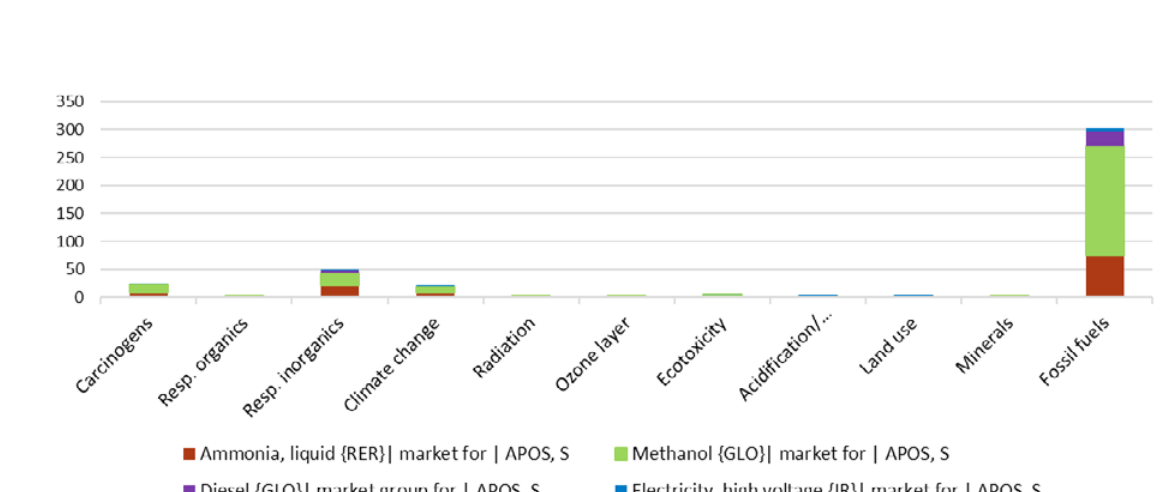
Figure 5. Results of applying weighting coefficients of the Eco-indicator 99 method in calculating impacts